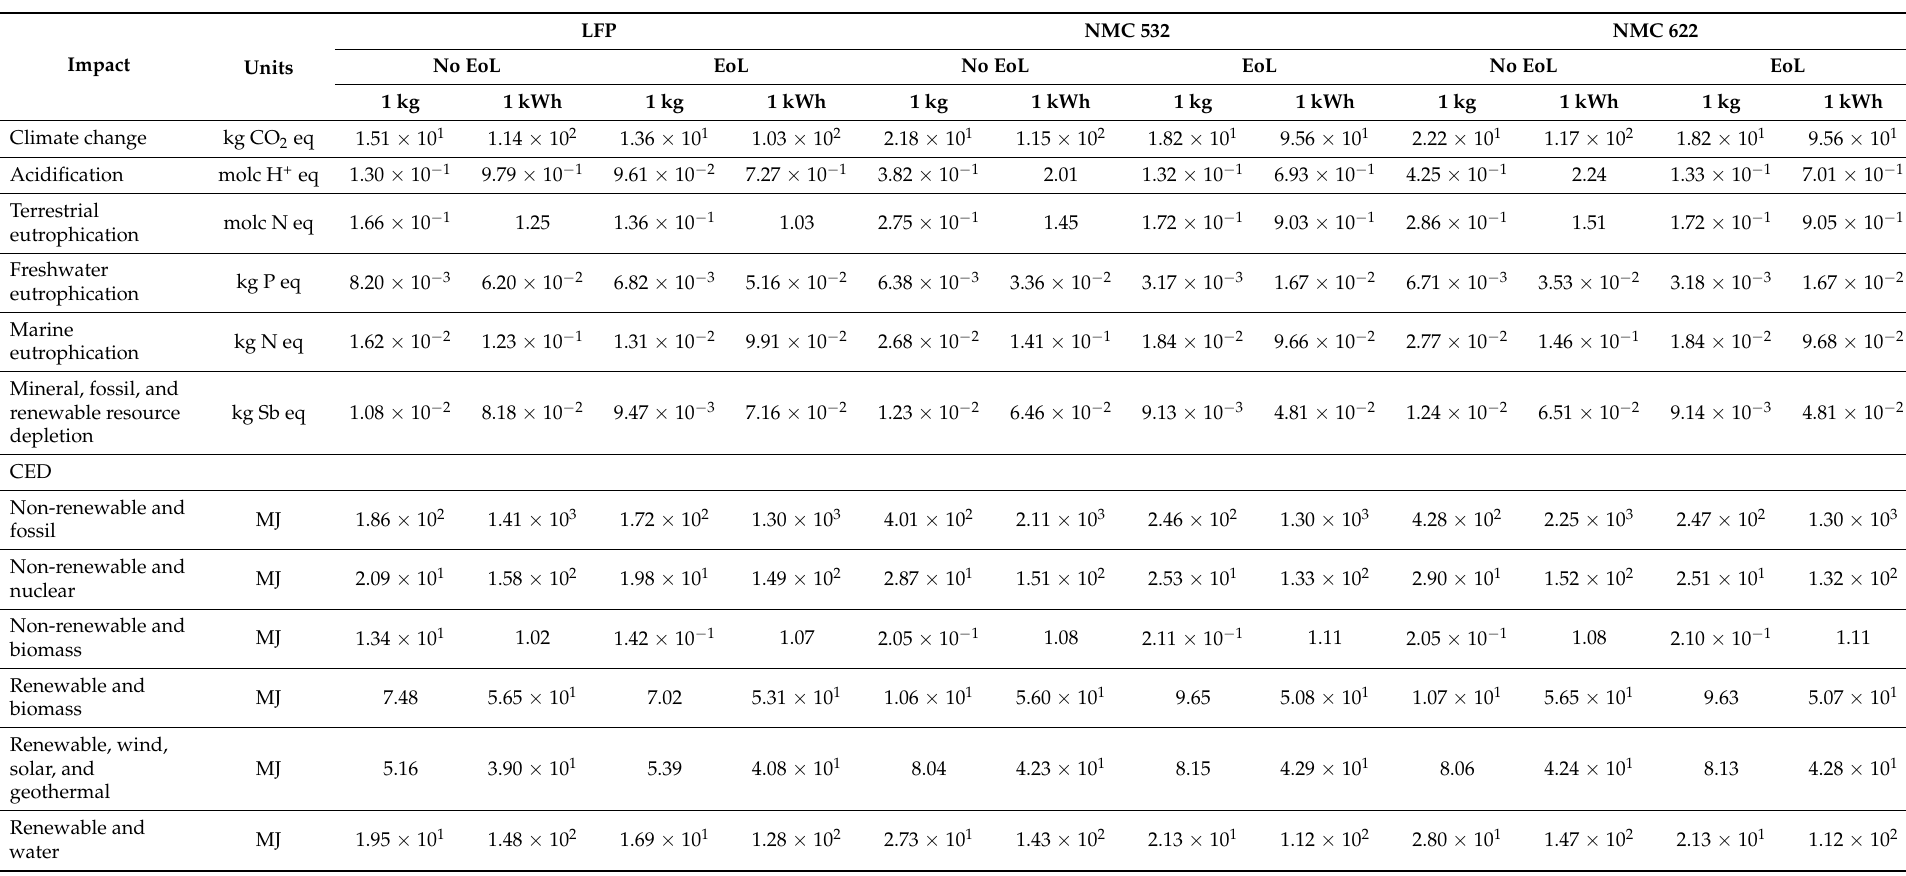
Table 7. Life cycle impacts of battery (LFP, NMC 532, and NMC 622) production and end-of-life (EoL) phase. Data are quantitatively reported for different functional units (1 kg and 1 kWh battery